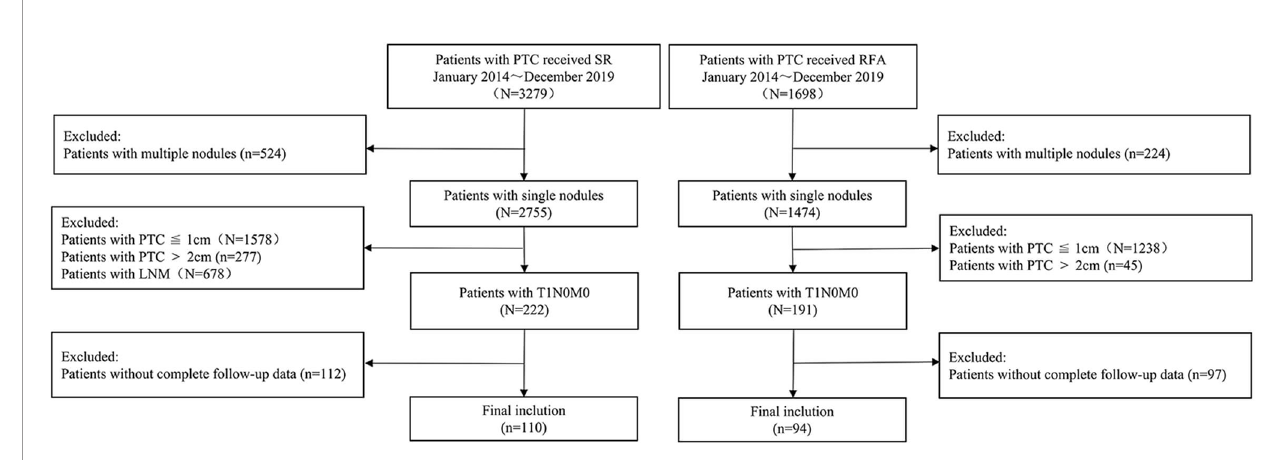
FIGURE 1 | Flowchart of